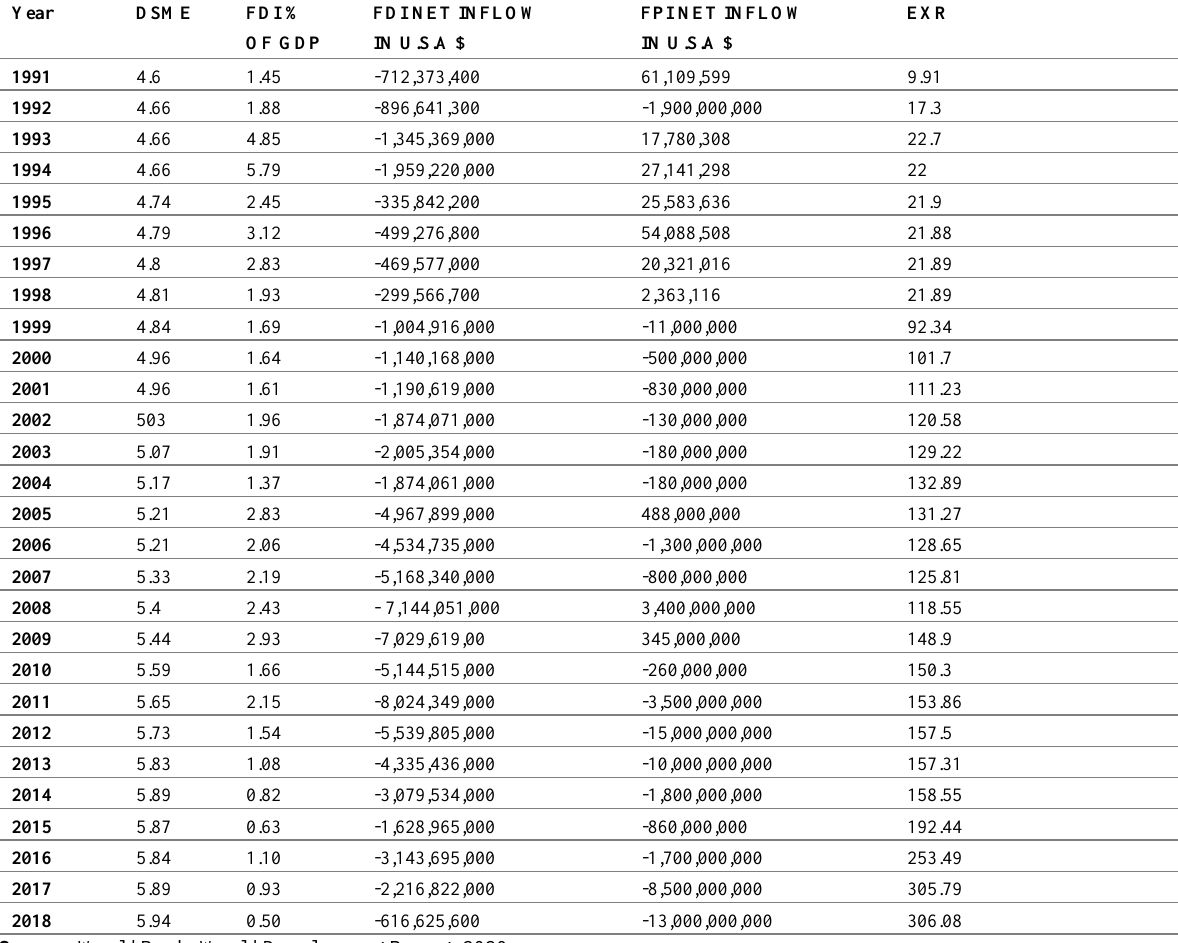
Table 3: DSME And Net FPI